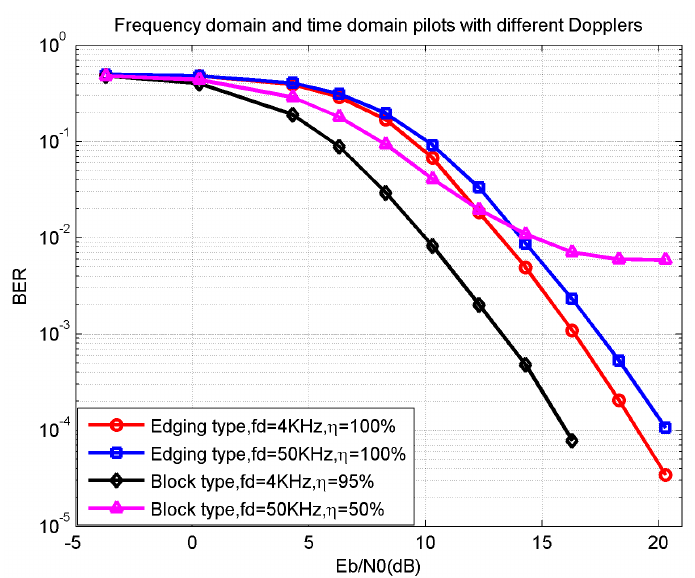
Figure 8. BER and efficiency between frequency domain and time domain pilots with different Dopplers.